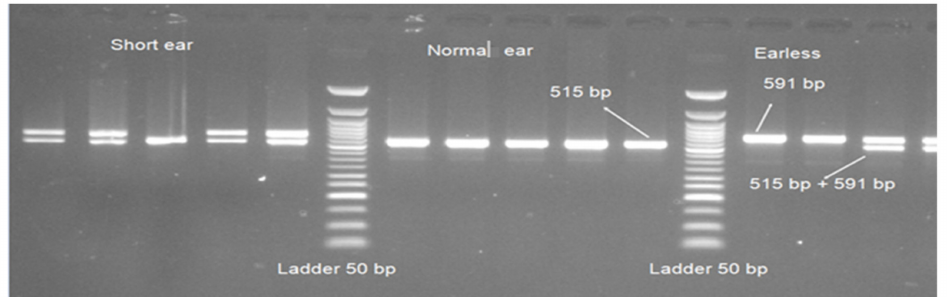
Figure 3. Polymerase chain reaction (PCR) products of ECR near HMX1 gene and Ladder 50 bp in 1.5% agarose